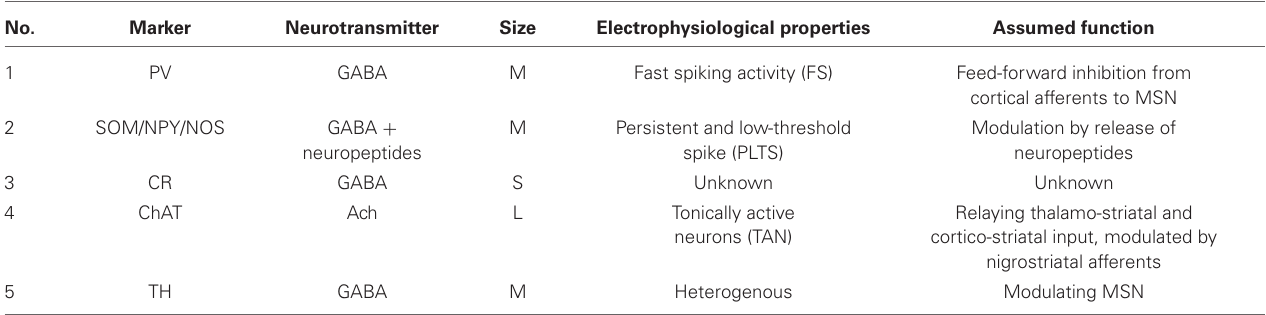
Table 1 | Overview of striatal